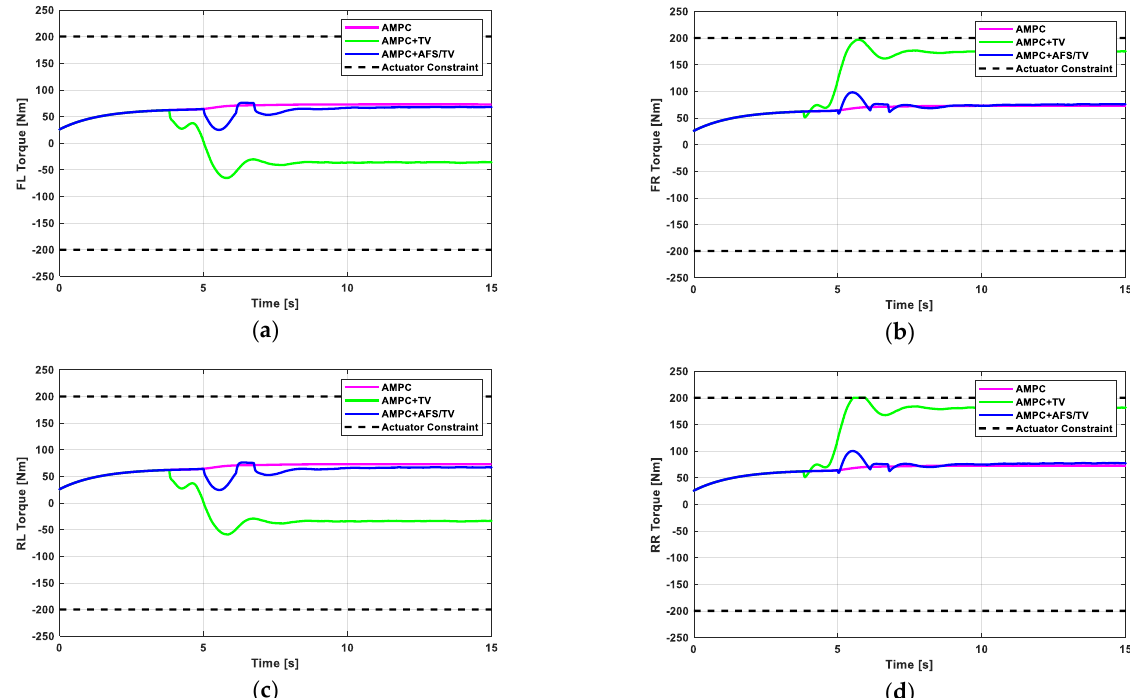
Figure 14. Torque distribution: ( a ) front-left, ( b ) front-right, ( c ) rear-left, and ( d ) rear-right.